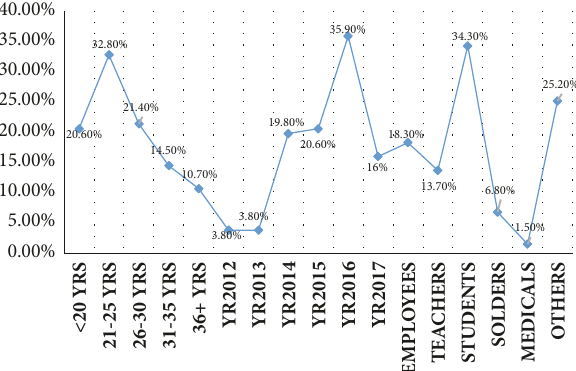
Figure 1: Description of the study population by age, year of admission, and occupations.